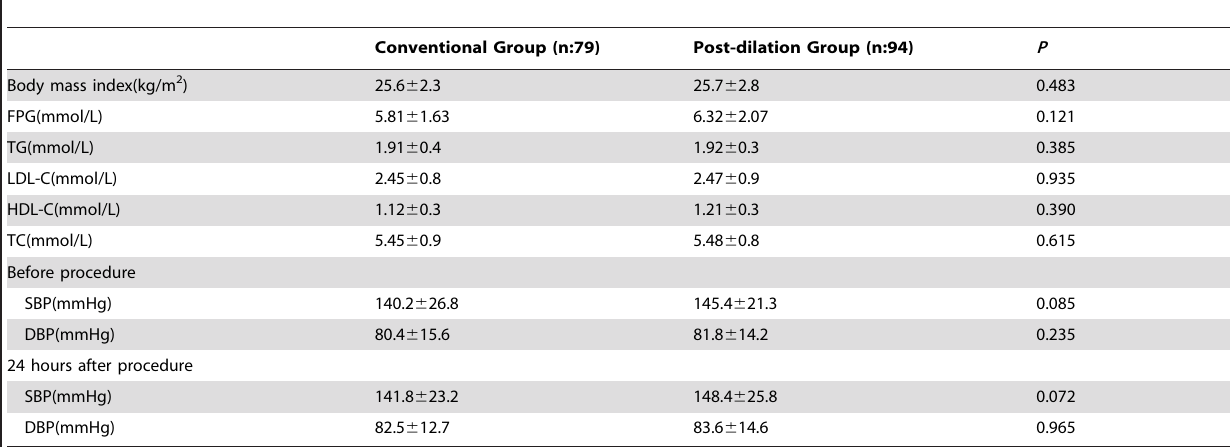
Table 2. Clinical and Biochemical Parameters of Patients in both groups( X